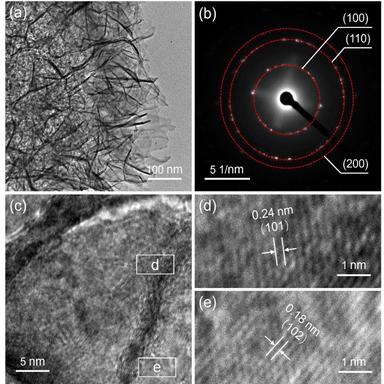
(a) TEM image of β-Co(OH)2 microflowers focused on some nanosheets, and (b) the corresponding SAED pattern as well as (c-e) HRTEM images of β-phase Co (OH)2 microflowers.